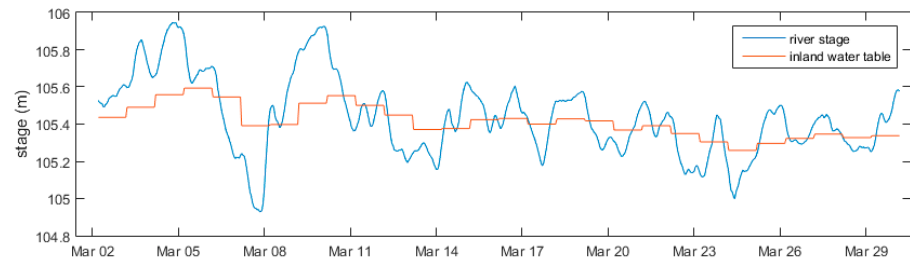
Figure 10. Time series of river stage and inland water level during the iButton monitoring period.